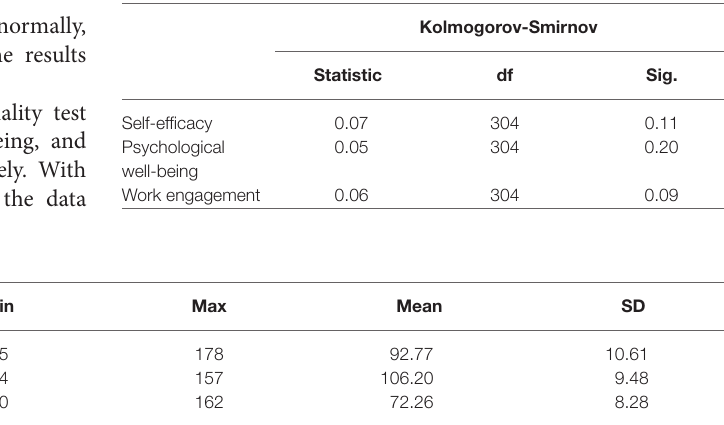
TABLE 1 | The results of the normality test (K-S).